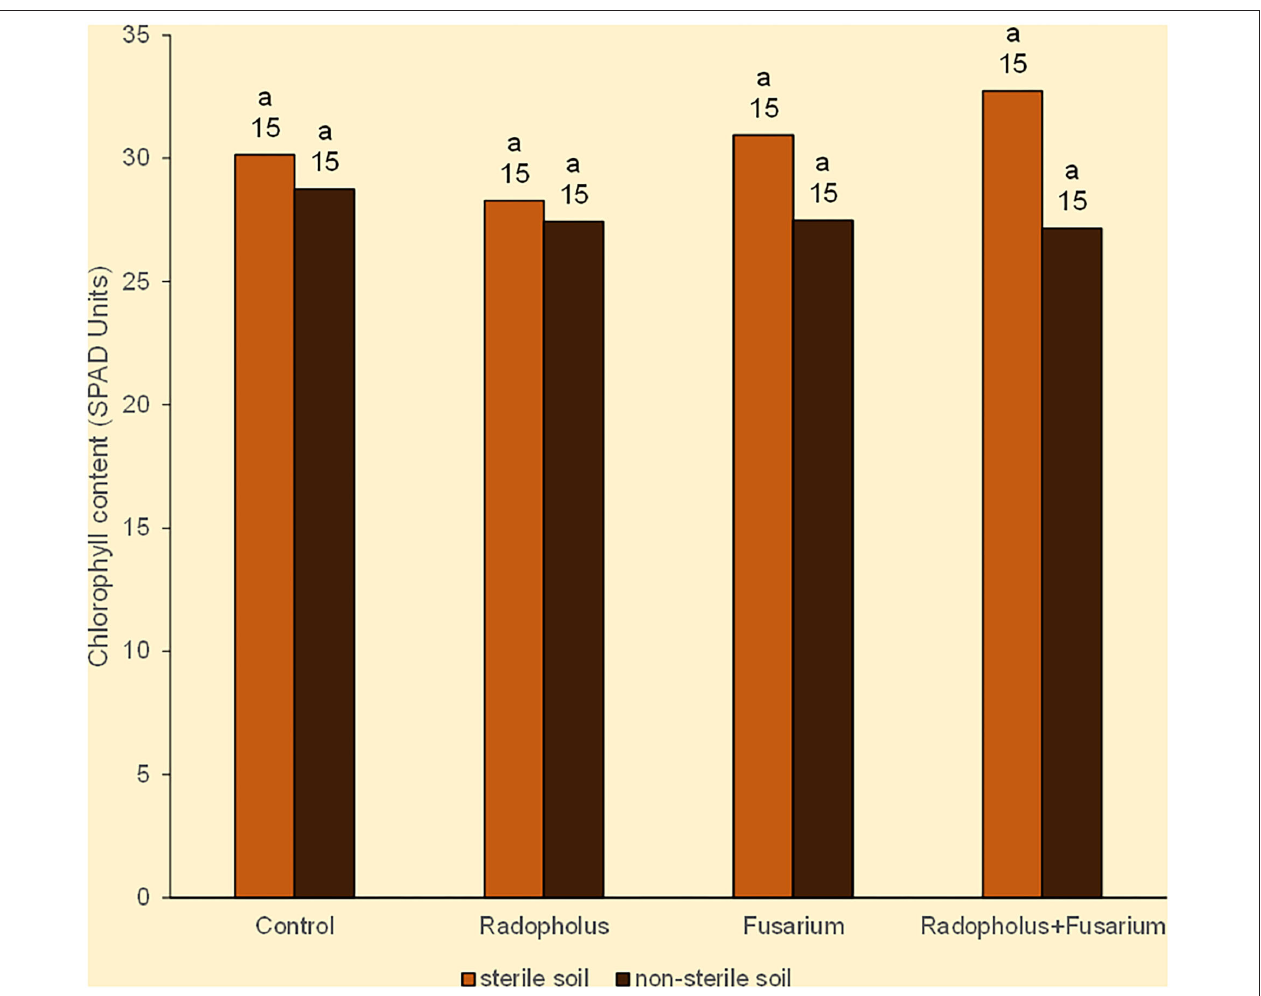
FIGURE 1 | Chlorophyll content in Nitrogen-starved tissue culture banana plants subjected to independent or combined inoculation with Radopholus similis and the Fusarium oxysporum V5w2 and grown in sterile or non-sterile soil. Bars with the same letter represent values that are not statistically different, with the sample sizes indicated below the letters ( χ 2 -test, p <